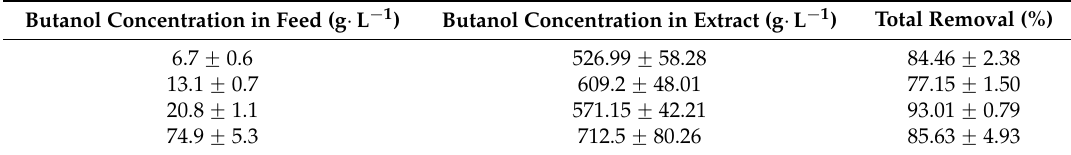
Table 3. Butanol concentration in extract (g·L − 1 ) and total removal (%) at different concentrations of butanol in the feed solution.